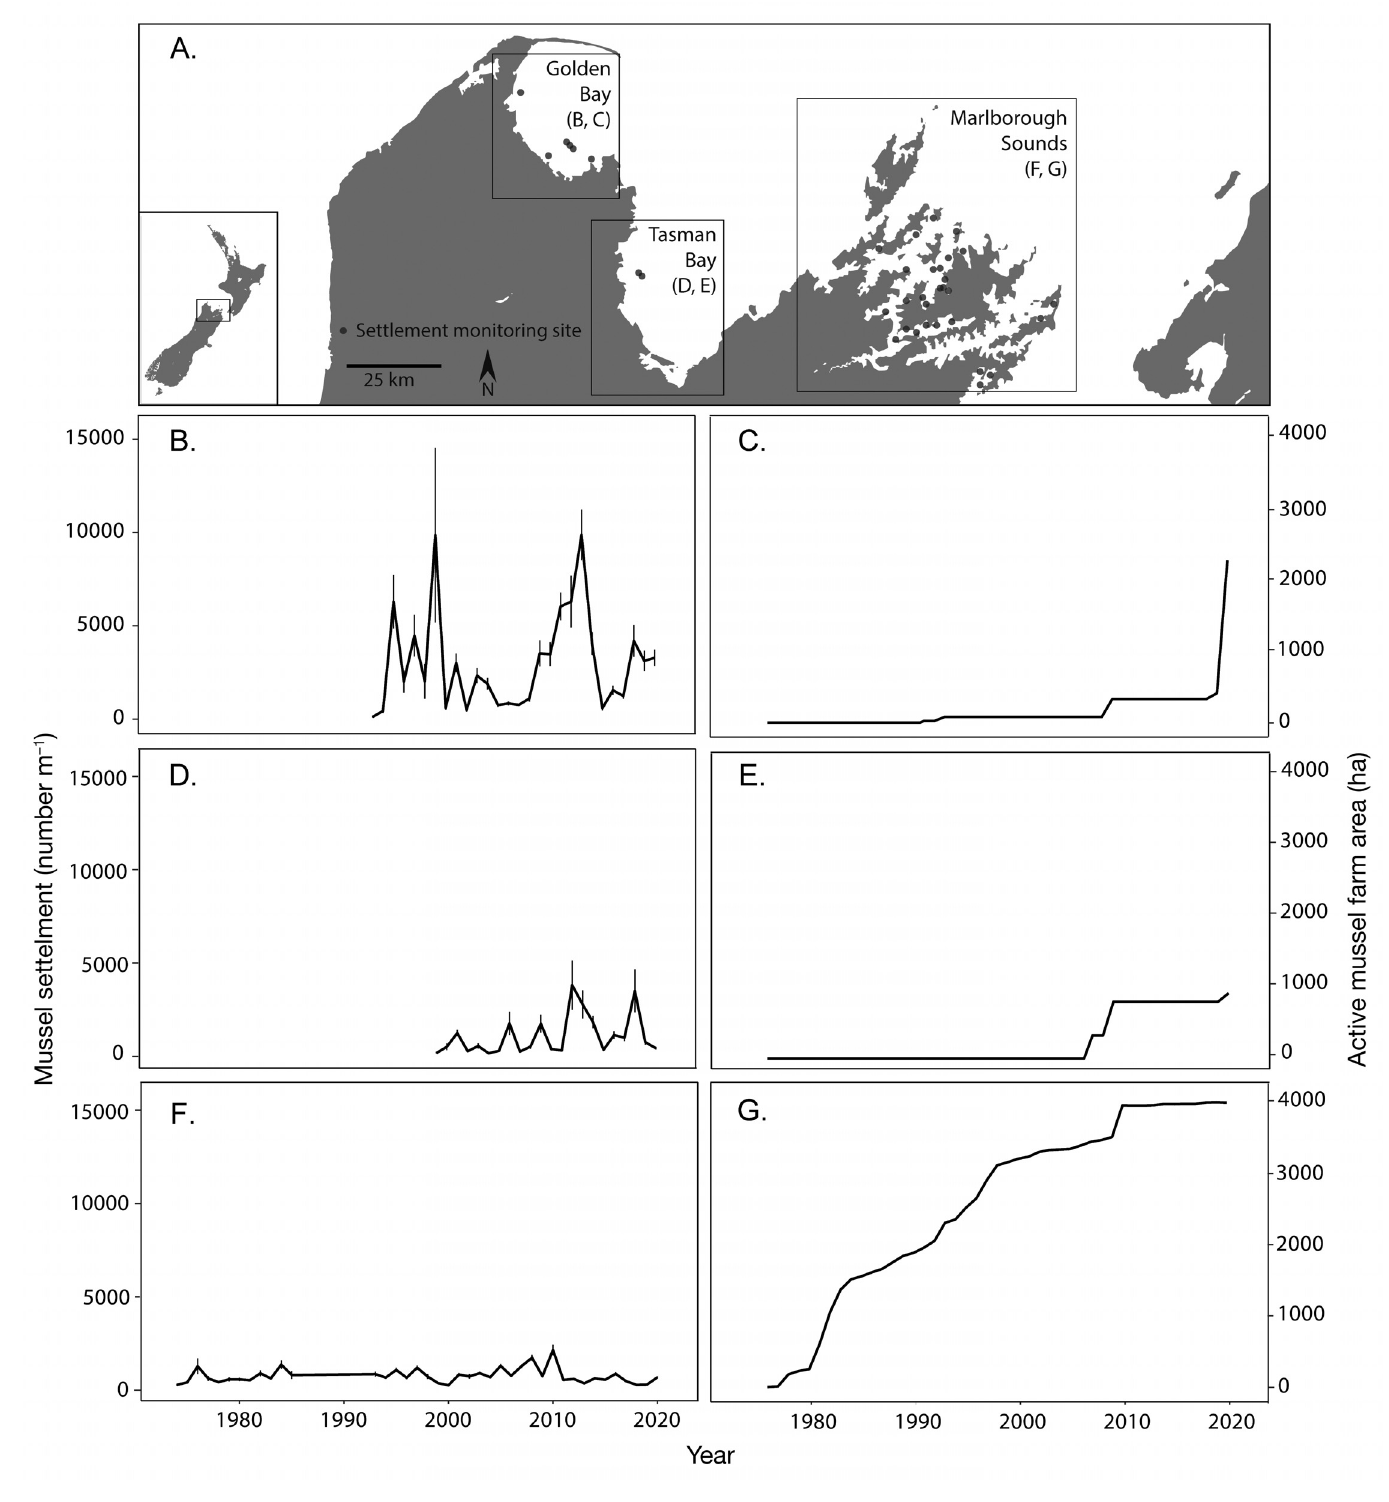
Fig. 3. Mean mussel settlement and total area of active mussel aquaculture in the study region. (A) Settlement monitoring sites (grey circles) in the major areas in the study region. (B,D,F) Mean weekly green-lipped mussel settlement per metre of sam- pling rope in each area per year. Error bars show SE. (C,E,G) Total area of mussel aquaculture under active permit in each study area per